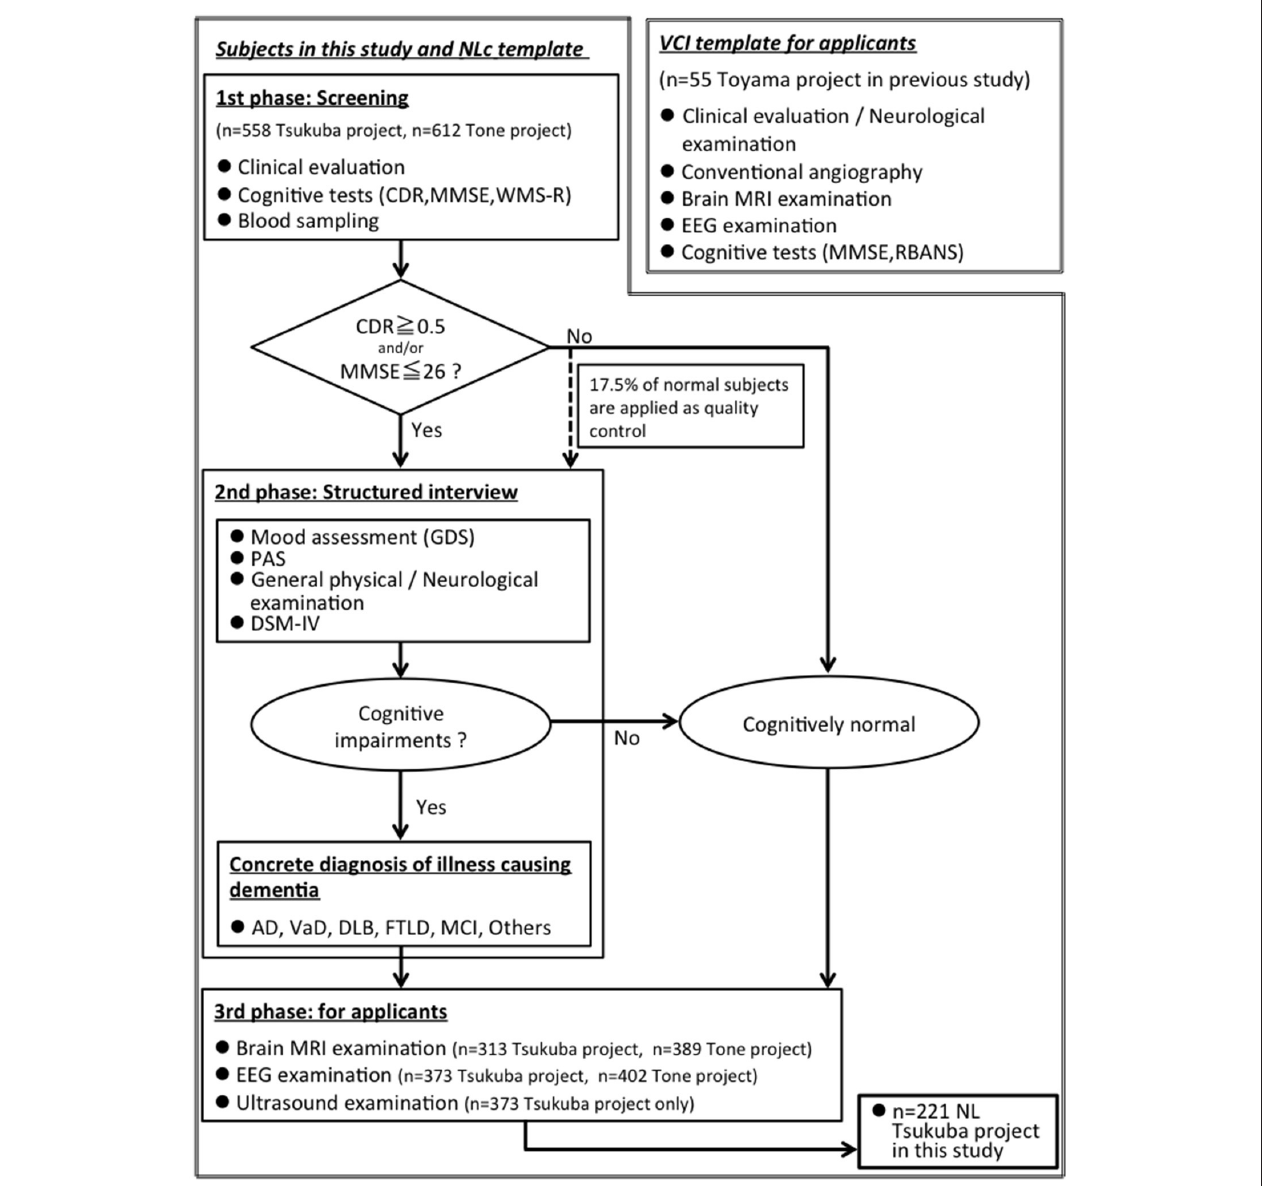
FIGURE 1 | A flow chart for understanding two groups: (1) elderly group: community-dwelling elderly subjects from Tsukuba city, n = 221, (2) VCI group: VCI patients from Toyama city (Shibata et al., 2014), n = 55. MMSE, Mini-Mental State Examination; CDR, Clinical Dementia Rating; WMS-R, “logical memory A” from the Wechsler Memory Scale-Revised; PAS, Psychogeriatric Assessment Scales; RBANS, Repeatable Battery for the Assessment of Neuropsychological Status; GDS, Geriatric Depression Scale-Short Form; DSM-IV, Diagnostic and Statistical Manual of Mental Disorders, 4th edition; AD, Alzheimer disease; VaD, Vascular dementia; DLB, Dementia with Lewy Bodies; FTLD, FrontoTemporal Lober Degeneration; MCI, Mild Cognitive Impairment.